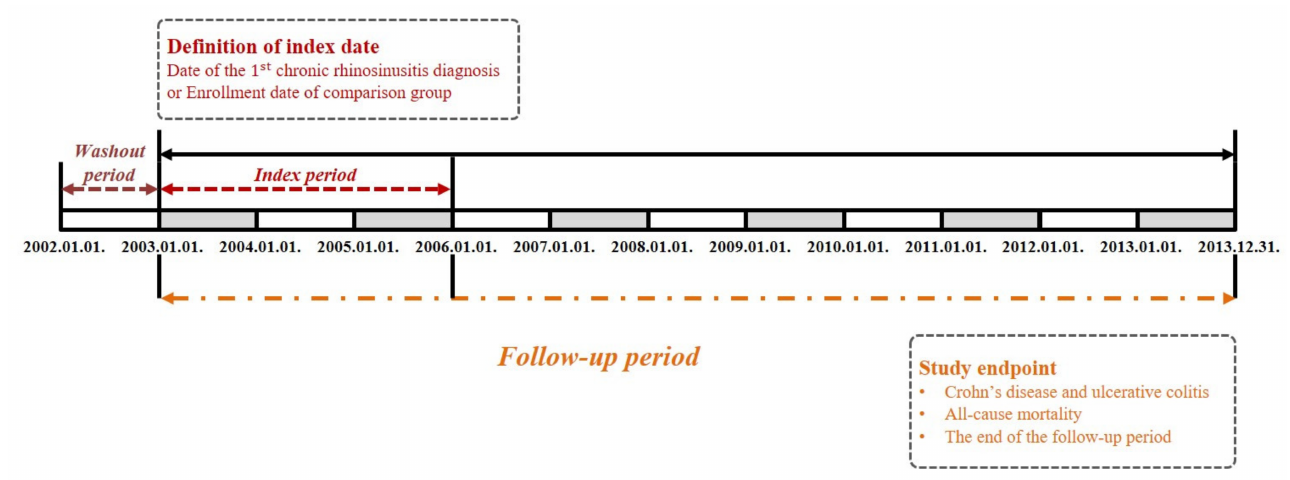
Figure 1. Schematic flow of the study